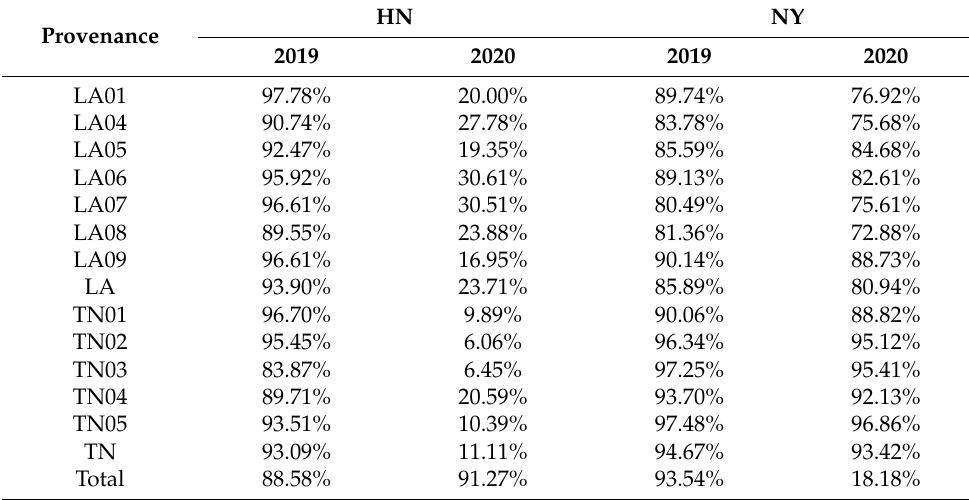
Table 3. Average survival rate.